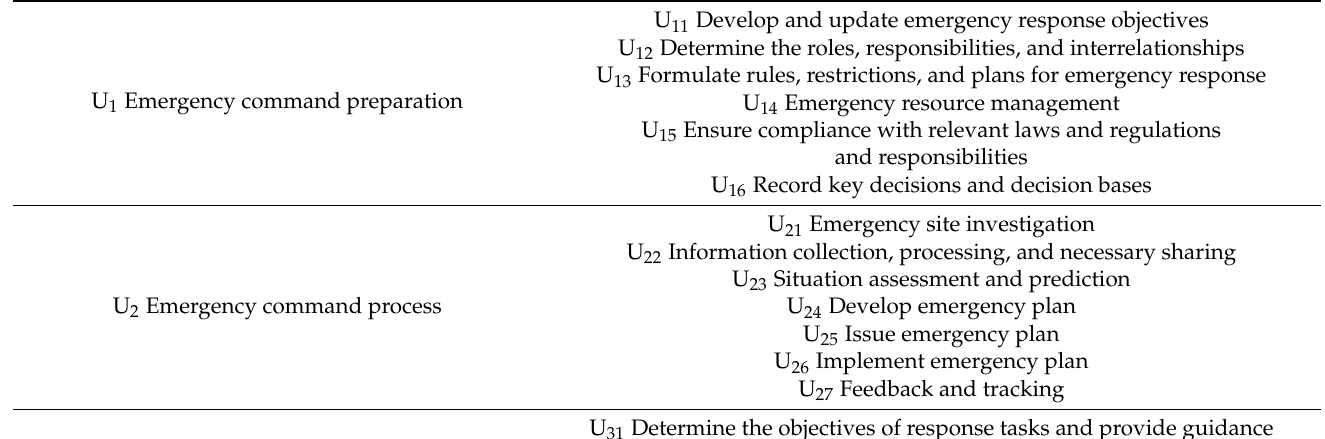
Table 1. Emergency response assessment indicator system inspired by